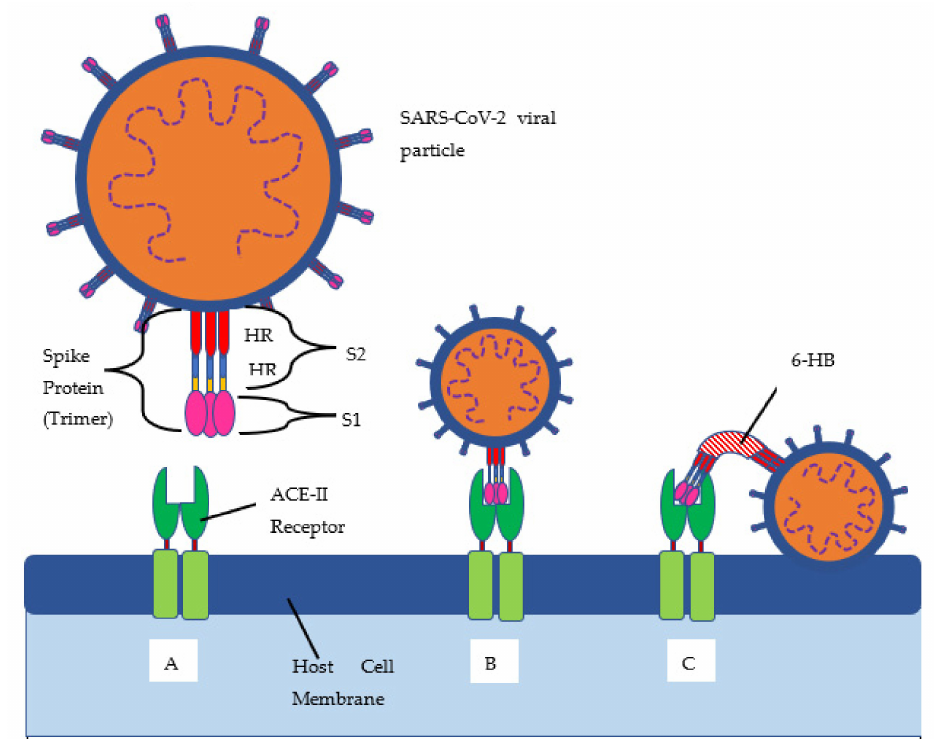
Figure 1. SARS-CoV-2 structure and binding schematic. ( A ) Native resting state of the ACE-II receptor on the host cell surface. ( B ) Spike protein binding to the ACE-II receptor. ( C ) Viral fusion with the host cell membrane. Host cell proteases cleave the spike protein into S1 and S2 subunits. S1 is responsible for binding to ACE-II, while S2 is responsible for viral fusion and entry. Upon S1 binding ACE-II, the HR 1 and 2 subunits form the 6-helix bundle (6-HB) in order to bring the viral particle close to the host cell to allow for fusion and entry